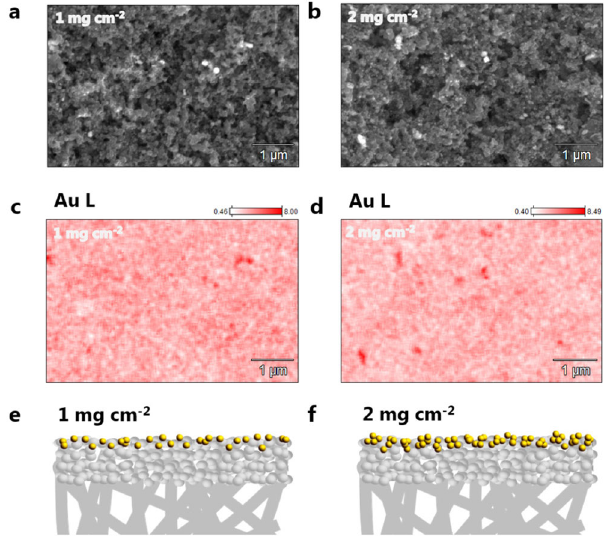
Fig. 4 Characterization of the GDEs with different catalyst loadings. a , b SEM micrographs, ( c , d ) EDX elemental map and ( e , f ) schematic representation of the gold GDEs with 1 mg cm − 2 and 2 mg cm − 2 loading, respectively.